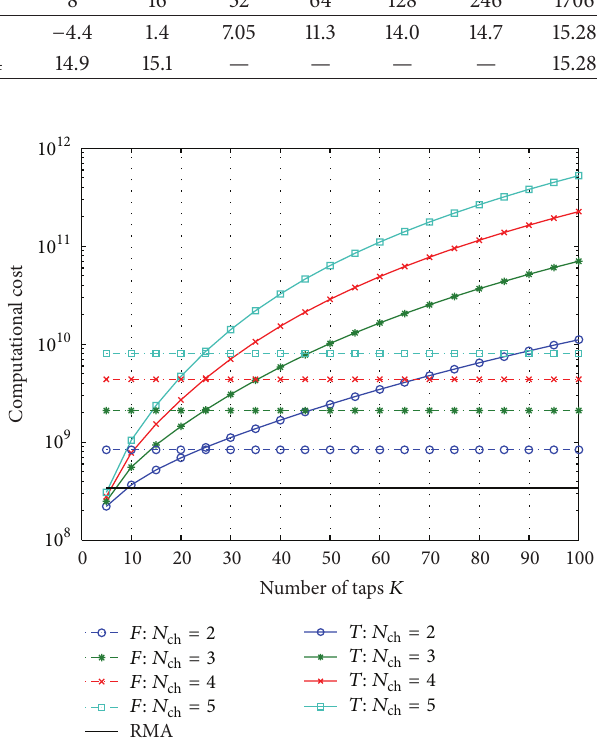
Figure9: ComparisonoftheoverallcomputationalcostoftheRMA and the WB nulling techniques in the time and in the frequency